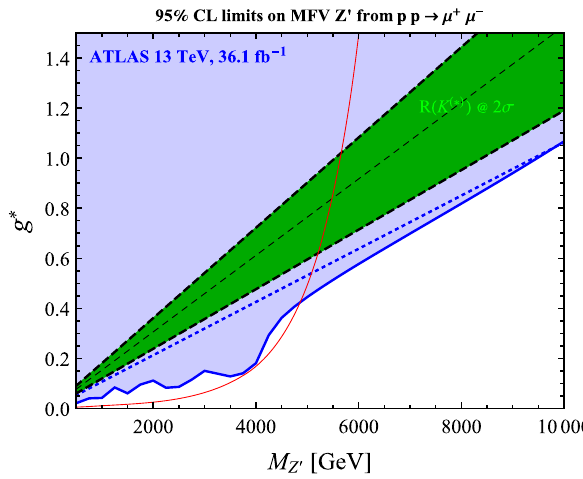
Fig. 5 Limits on the Z (cid:3) MFV model from pp → μ + μ − . See text for